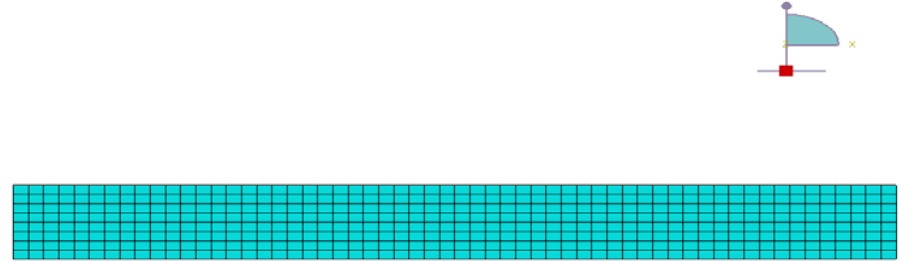
Figure 8. A meshed air-filled pipe model using the acoustic continuum axisymmetric 8-node element (ACAX8).